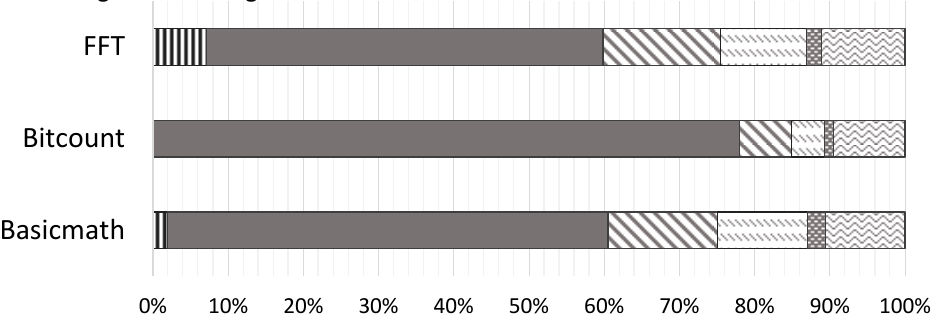
Figure 6. The dynamic instruction distribution for selected benchmarks.